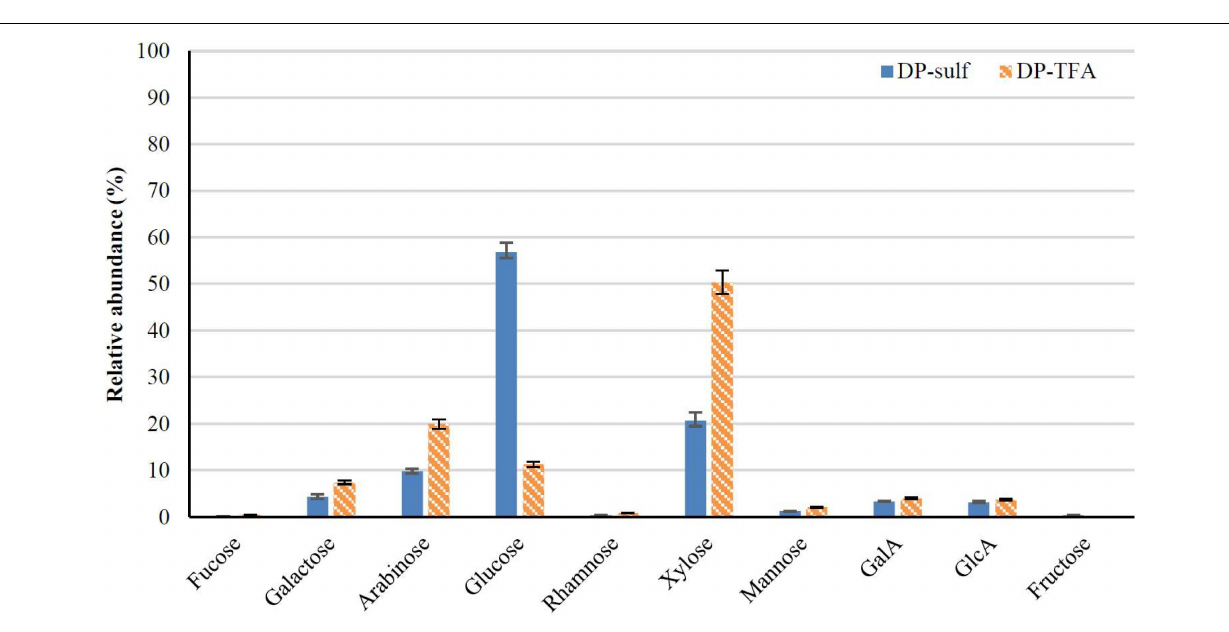
FIGURE 3 | Monosaccharide composition of DP calculated by TFA ( DP-TFA ) and sulfuric acid hydrolysis ( DP-sulf ), expressed as relative abundance (%, g per 100 g of total free sugars) ( n = 3, mean ±